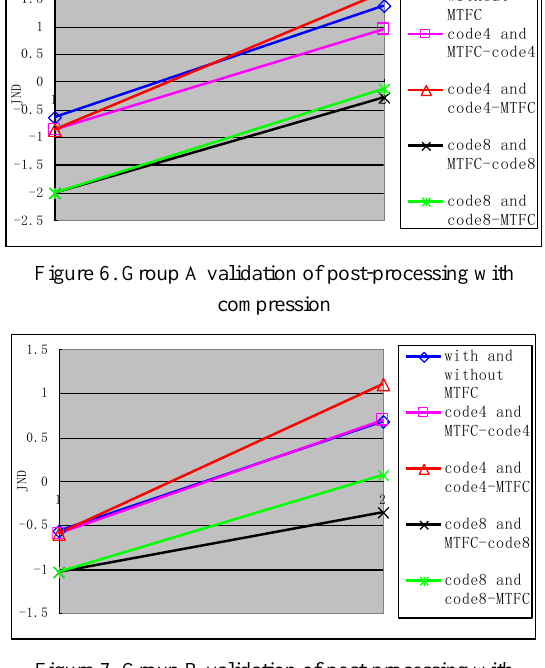
Figure 7. Group B validation of post-processing with